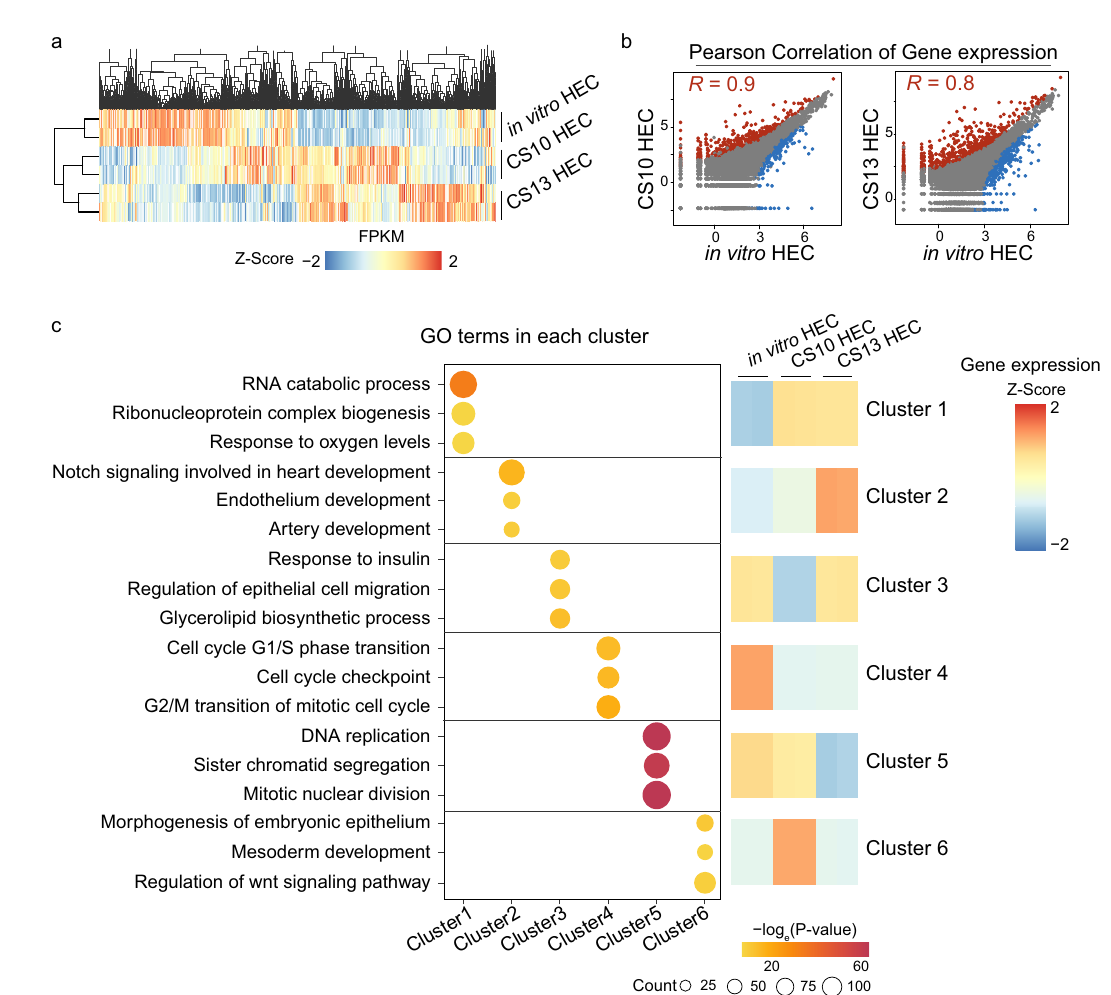
Fig. 4 ScRNA-seq and scATAC-seq analysis revealed subpopulations of ECs and early HPCs. a Schematic showing the sample collection for single-cell RNA-seq and ATAC-seq. Dots indicate the different types of cells in the culture dish. b UMAP visualization of HPC, EC, Mes, and Epi clusters resulted from scRNA-seq of differentiation day 6 cells. c UMAP visualization of HPC, EC, Mes, and Epi clusters resulted from scATAC-seq data. d ScATAC-seq peaks around the CD34 locus. The new emerged open regions are shaded. e UMAP plot of scRNA-seq (left) and scATAC-seq (right) of the AEC TI, AEC TII, pre- HPC TI, pre-HPC TII, and HE clusters, derived from re-clustering EC and HPC populations described in b . f Heatmap showing the expression of top DEGs in AEC TI, AEC TII, pre-HPC TI, pre-HPC TII, and HE populations. g , h Cell cycle and trajectory analyses of AEC TI, AEC TII, pre-HPC TI, pre-HPC TII, and HE populations. i Expression of representative HPC and AEC related genes during the EHT process in AEC TI, AEC TII, pre-HPC TI, pre-HPC TII, and HE populations. hPSC human pluripotent stem cell. VME vascular mesoderm cell, EPC endothelial progenitor cell, HPC hematopoietic progenitor cell, Epi epithelial cell, Mes mesoderm cell, EC endothelial cell, HE hemogenic endothelium, AEC arterial endothelial cell, AEC TI, AEC-type I, AEC TII, AEC-type II,